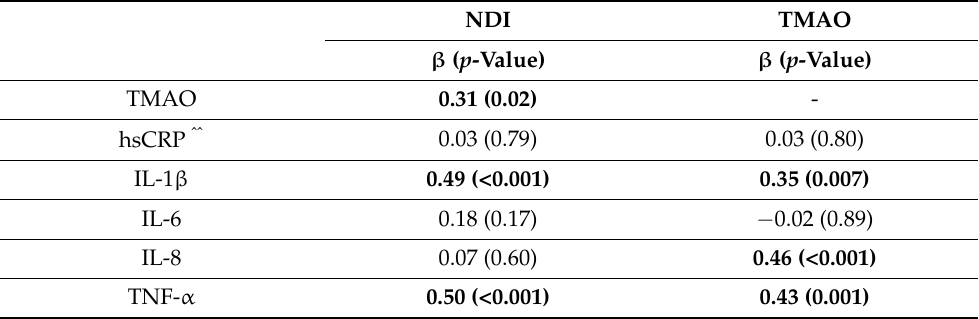
Bold indicates p -value < 0.05. ˆˆ hs-CRP was undetectable in one individual ( n = 59). ASCVD risk score includes sex, age, race, total cholesterol, HDL-C, systolic blood pressure, personal history of diabetes, personal history of smoking, personal history of treatment for hypertension. ASCVD: atherosclerotic cardiovascular disease; BMI: body mass index; TG: triglyceride; hs-CRP: high-sensitivity C-reactive protein; IL: interleukin; TNF: tumor necrosis factor.